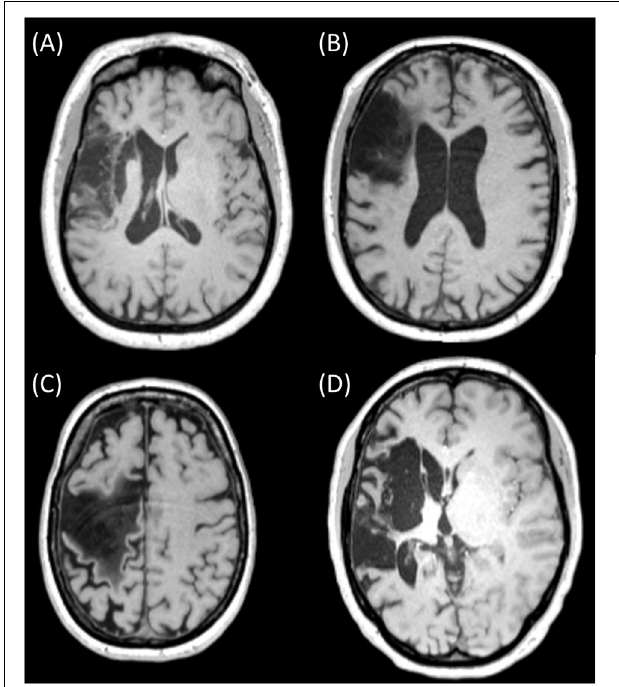
FIGURE 1 | MRI slices of four different chronic stroke subjects showing lesions of various sizes and mixed composition [ (A) (subject 042), (B) (subject 034), and (C) (subject 051)] and with primarily CSF [ (D) (subject 055)]. Ethical approval was acquired to record and publish the MRI slices with consent from the participants (see